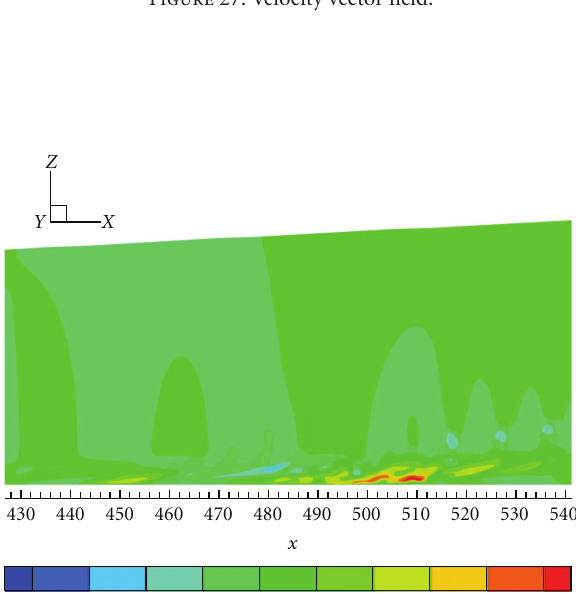
lead to loss of symmetry and randomization for the whole flow field